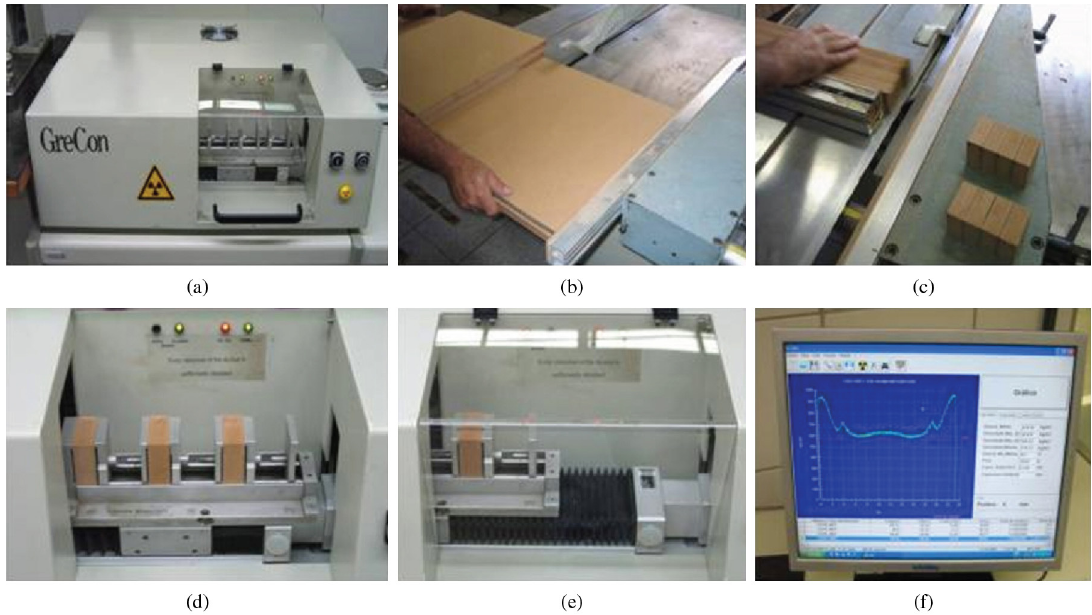
Figure 2. For obtaining the densitometric profile, the device